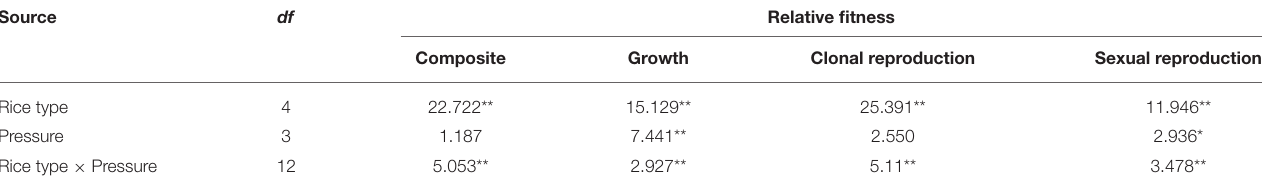
TABLE 3 | F -values generated from two-way ANOVA testing the effects of rice type, insect pressure levels, and their interaction on fitness at different life-history stages and across the lifetime.